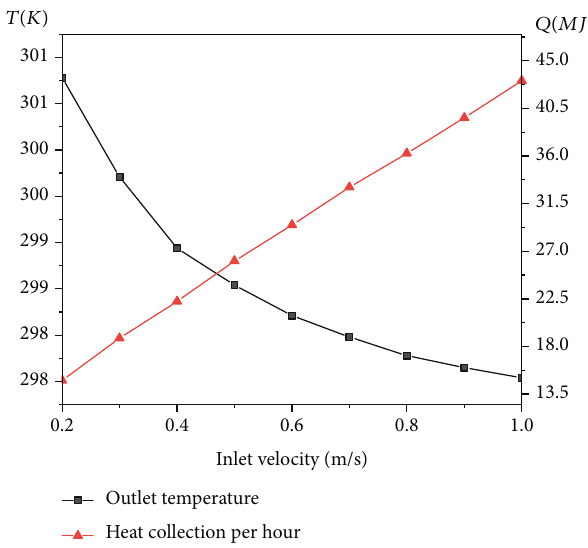
Figure 6: Outlet temperature and hourly heat collection of heat